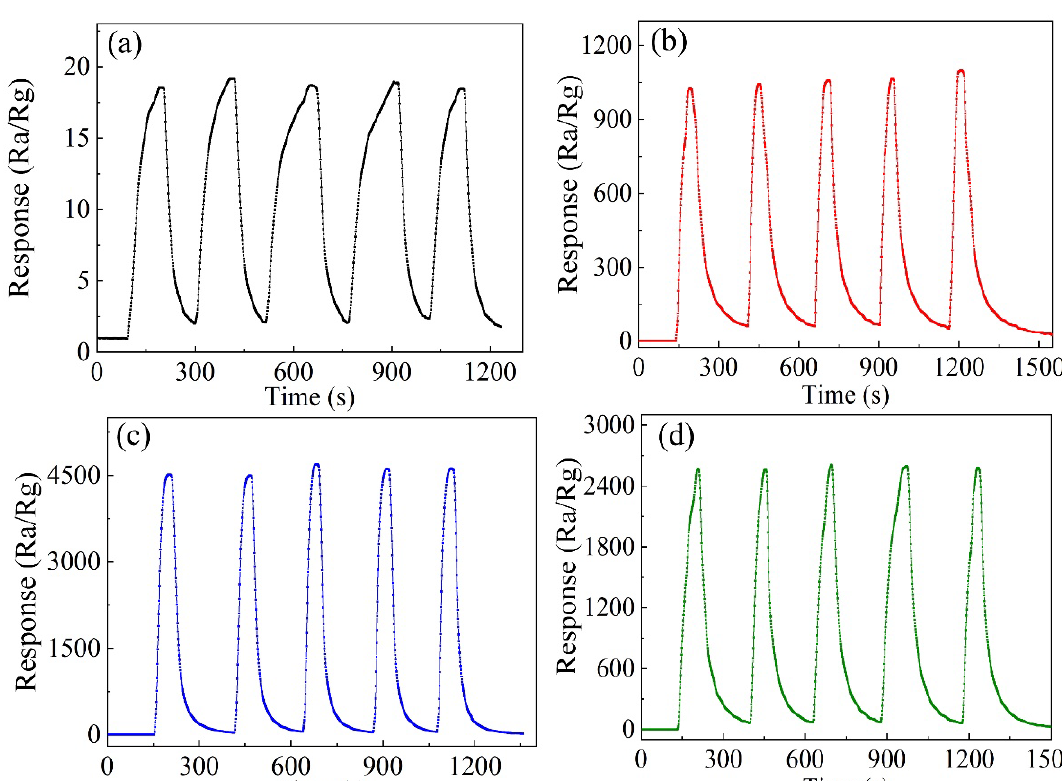
Figure 7. The selectivity of all samples for different gases.